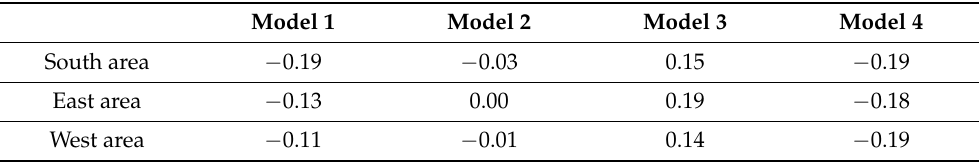
Figure 7. PPD and PMV values for Model 4 using clo 0.7 in cooling season in different areas (south, east, and west). Table 4. Average PMV values for different areas (south, east, and west) and different